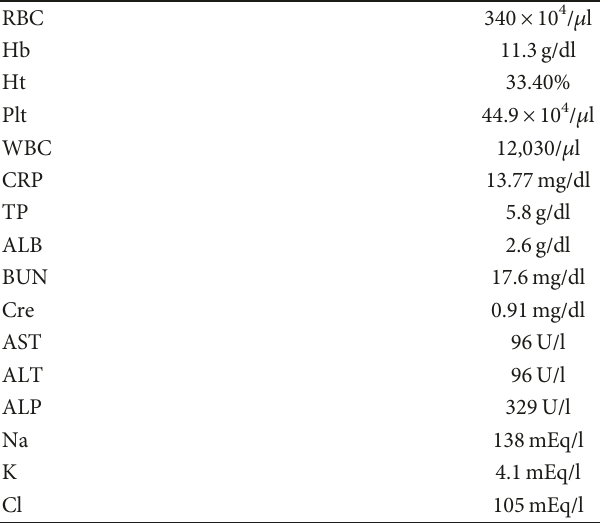
Figure 1: X-ray fi lms of the lumbar spine. Severe spinal degeneration, but no signs of lumbar fracture, was Figure 2: Magnetic resonance images of the lumbar spine. High- intensity lesion at the L5/S disc without epidural abscess was Table 1: Laboratory data. detected on a T2-weighted image (a). A low-intensity lesion at the same level was detected on a T1-weighted image (b).